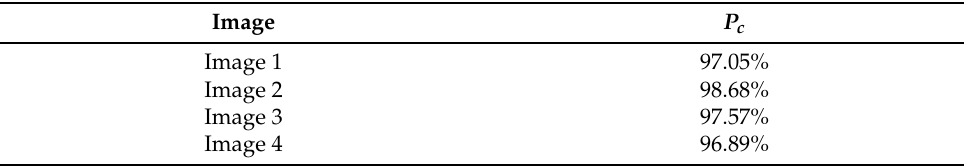
Table 1. Accuracy of sky region segmentation on four